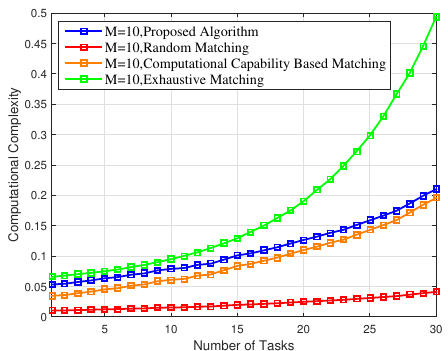
Figure 7. Computational complexity of the proposed scheme versus the random matching, CCBM, and exhaustive